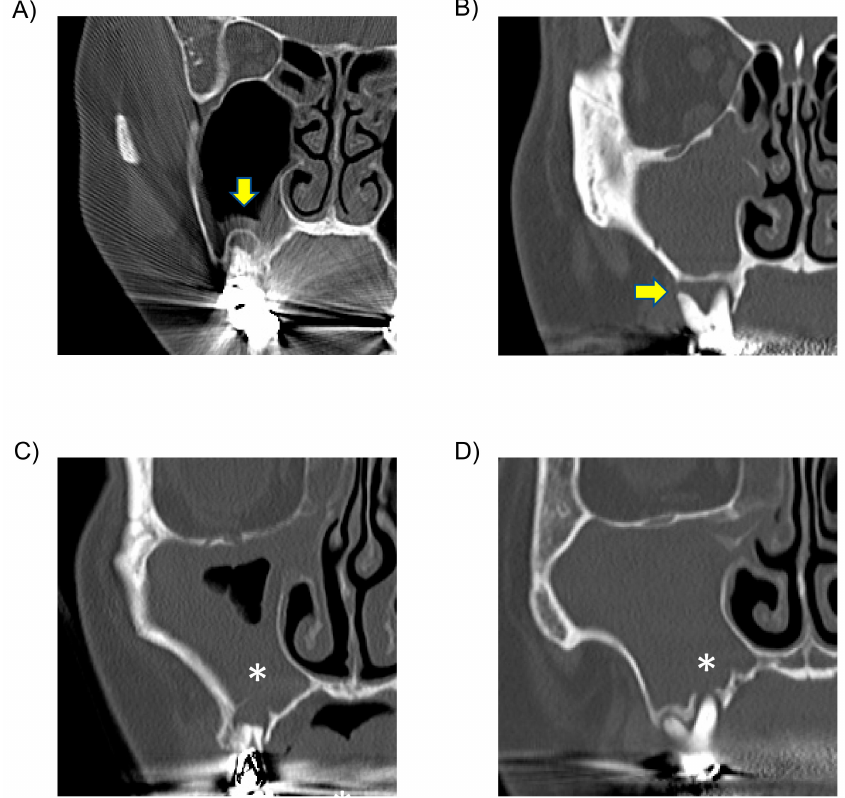
Figure 1. ( A ) Pyogenic periodontitis of the roots. (Case) A 46-year-old woman. A cystic lesion was found on the root apex of the right upper first molar. The yellow arrow points to the root apex lesion; ( B ) Marginal periodontitis. (Case) A 40-year-old woman. There is bone resorption around the alveolar bone of the right upper first molar. A yellow arrow points to the root apex lesion. ( C ) Pyogenic radicular periodontitis. Fistulae into the maxillary sinus are found in the area indicated by the asterisk. ( D ) Marginal periodontitis. (Case) A 68-year-old woman. A fistula into the maxillary sinus was found in the right upper first molar as indicated by the